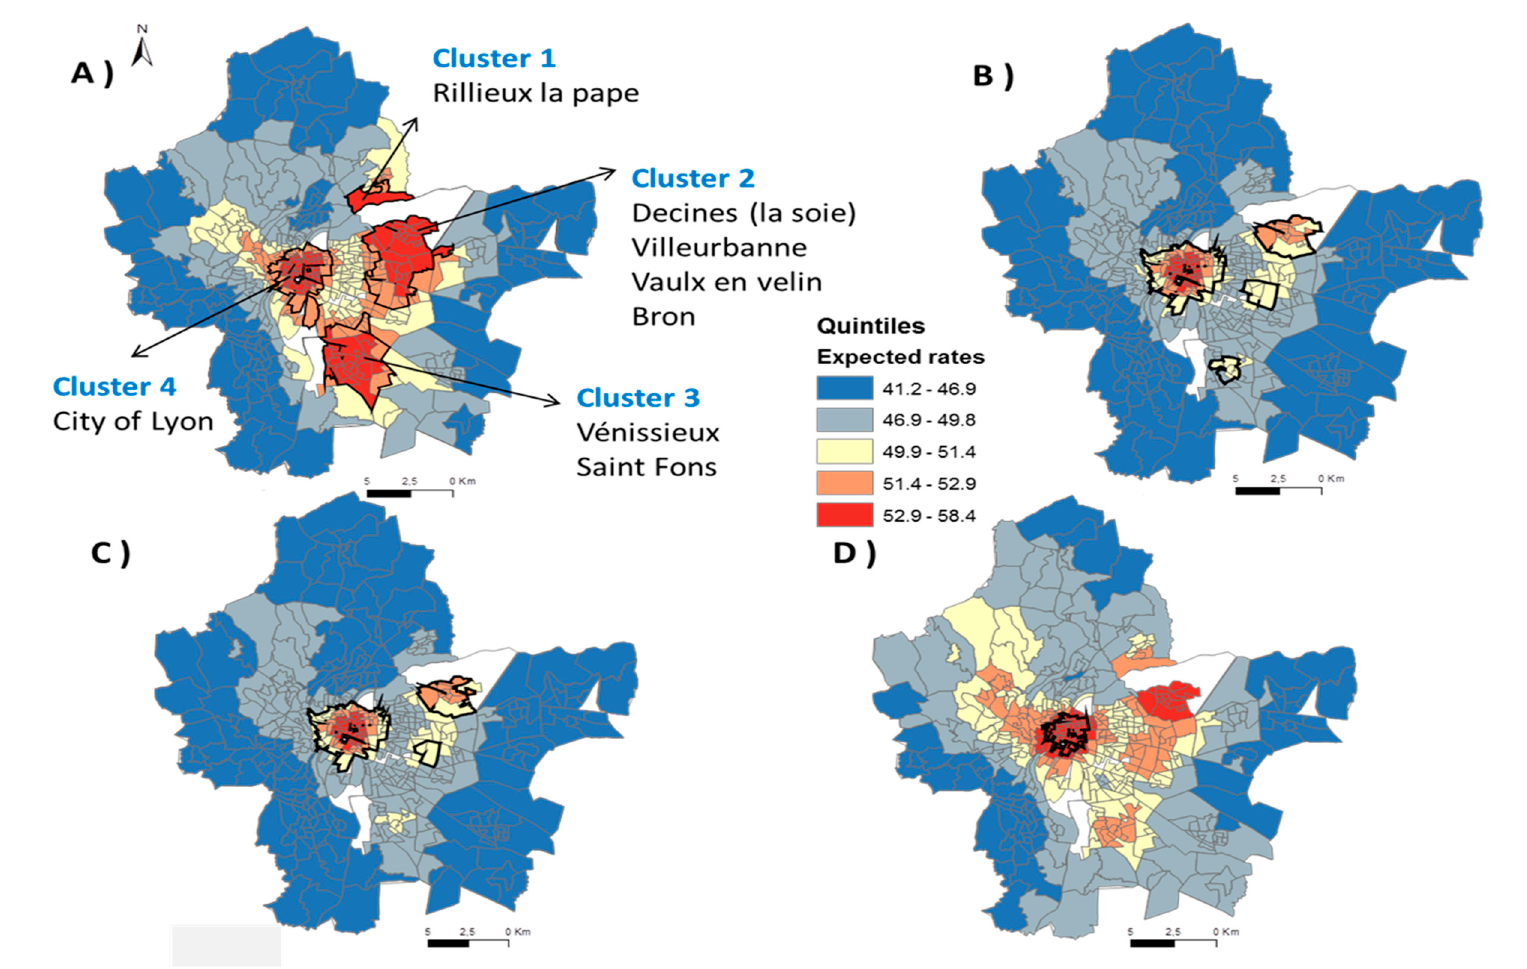
Figure 3. Estimated prevalence of non-participation of mammography screening by the GAMs in the Lyon MA for the crude model ( A ), according to ( B ) the deprivation index, ( C ) SES and individual screening and ( D ) SES and women aged 50 years and more. Solid lines identify areas with significantly lower participation rates of mammography screening compared to the rest of the study settings (hotspots).